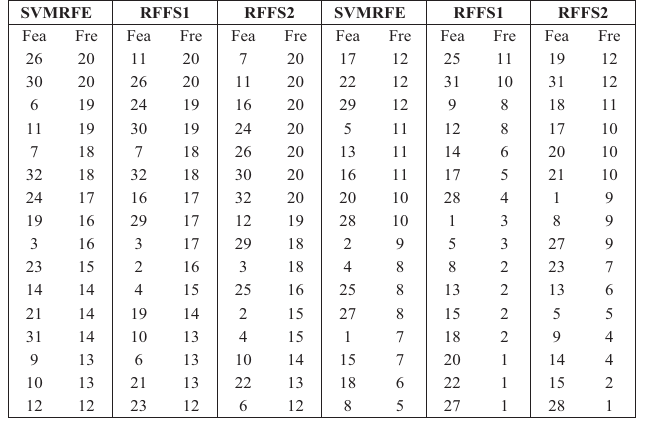
Figure A4. SVMRFE and RFFS results of SBM data, where Fea represents the feature number and Fre represents the frequency at which the feature appears in 20 experiments.